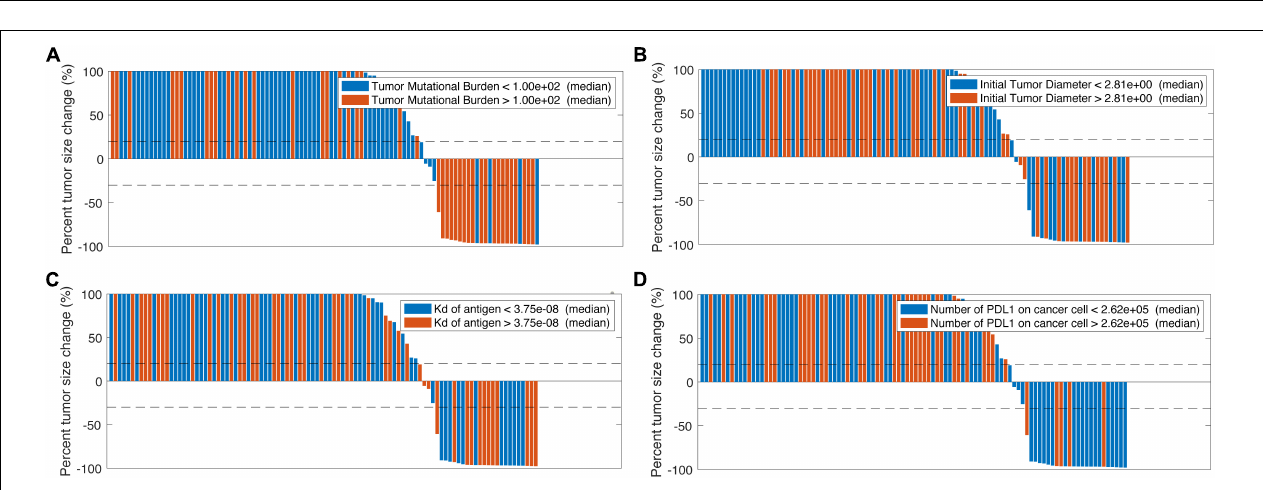
FIGURE 4 | Anti-tumor activity of triple combination therapy in virtual patient cohort. Total 1196 virtual patients in triple combination of entinostat, nivolumab, and ipilimumab are divided into subgroups based on the population medians, and the objective response rates in each subgroup are calculated with 95% Agresti-Coull confidence intervals. MDSC, myeloid-derived suppressor cell; Ag, tumor antigen; TMB, tumor mutational burden (tumor-specific T cell clones in lymph nodes); Teff, effector T cell; Treg, regulatory T cell.